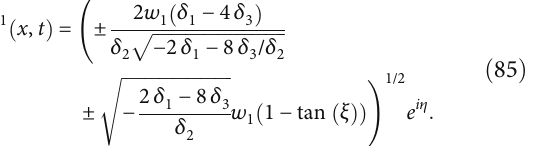
= 6, δ = δ = 0 : 6, δ 1 2 4